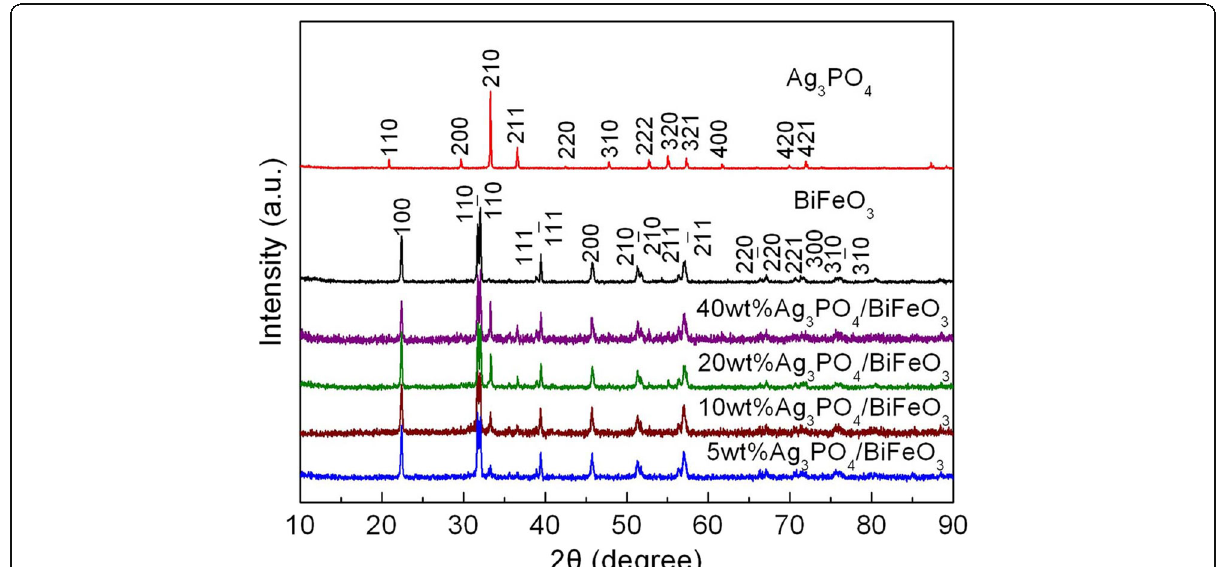
Fig. 1 XRD patterns of BiFeO 3 , Ag 3 PO 4 , and Ag 3 PO 4 /BiFeO 3